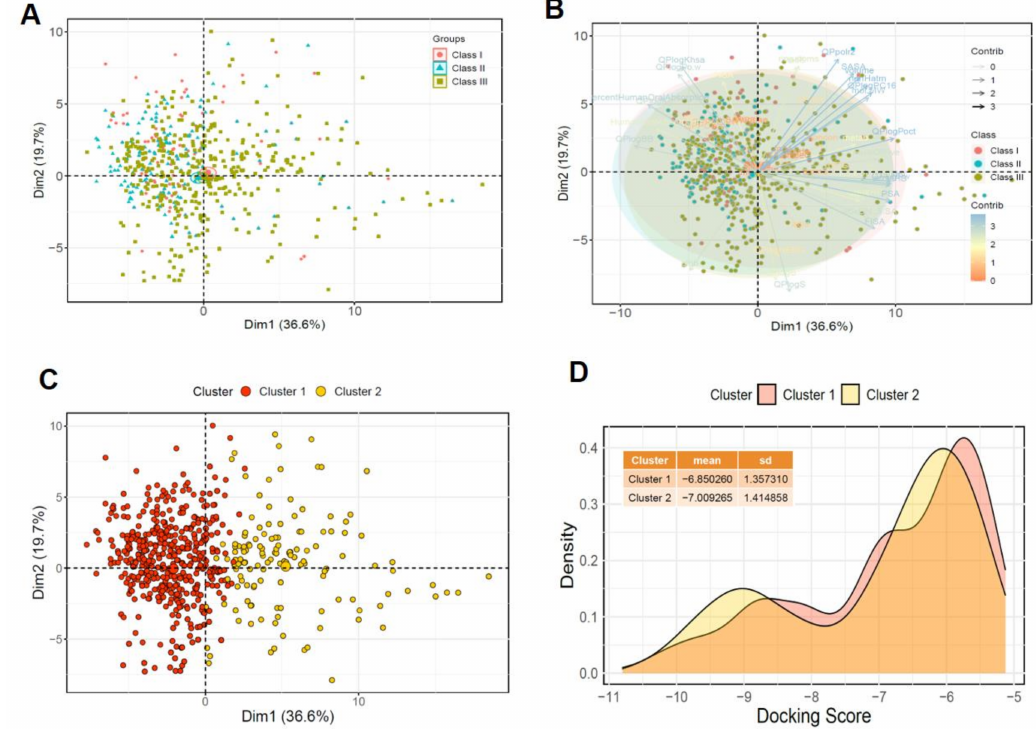
Figure 5. Visual representation of the chemical space and probability density curves of the Asfv PolX dataset. ( A ) PCA clustering plot of the chemical space of three classes across the Asfv PolX dataset. The red, blue, and green dots correspond to Class I, Class II, and Class III, respectively. ( B ) The loading plot vectors are represented by arrows for each physicochemical property. ( C ) The red and yellow dots correspond to Cluster 1 and Cluster 2, respectively. ( D ) The probability density curves of the Glide docking score. The X-axis represents the docking score of each structure-ligand pair, and the Y-axis represents the probability